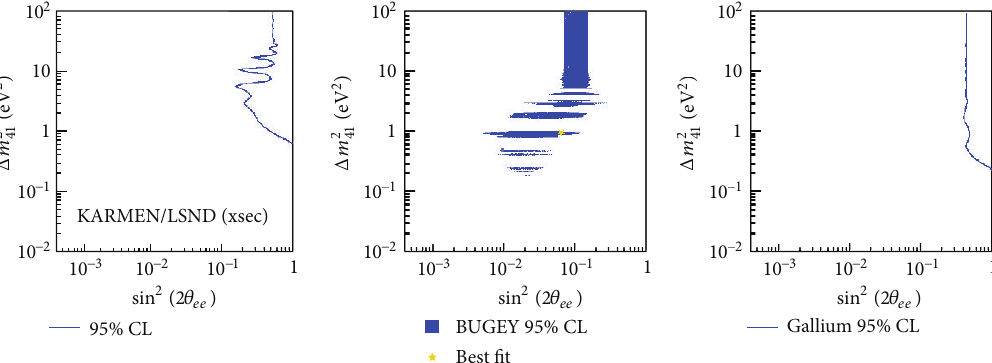
Figure 3: Summary of 𝜈 𝑒 → 𝜈 𝑒 and 𝜈 𝑒 → 𝜈 𝑒 results, shown at 95% CL. From left: KARMEN/LSND(xsec), Bugey, and Gallium. See Section 3.2 for details and